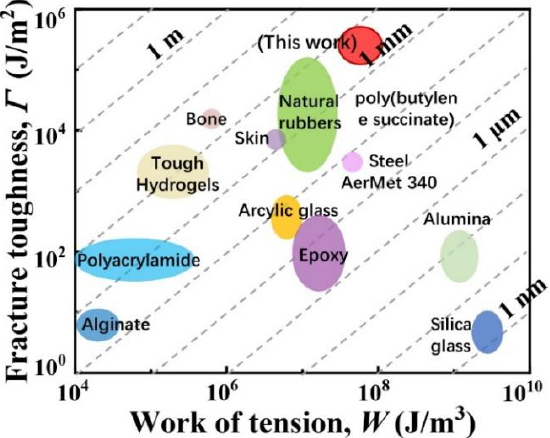
Figure 7. A space of material properties with fracture toughness Γ and the work of tension W on the axes. Also included are the slashes of constant values of the length of flaw sensitivity Γ / W . The stretchable materials in the current work are compared with other materials, e.g., nat- ural rubbers [29,30], polyacrylamide hydrogels [30], alginate hydrogels [30,31], and tough